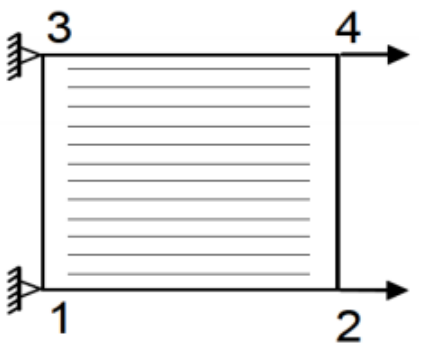
Figure 1. Single 4-node shell element under tension [51].